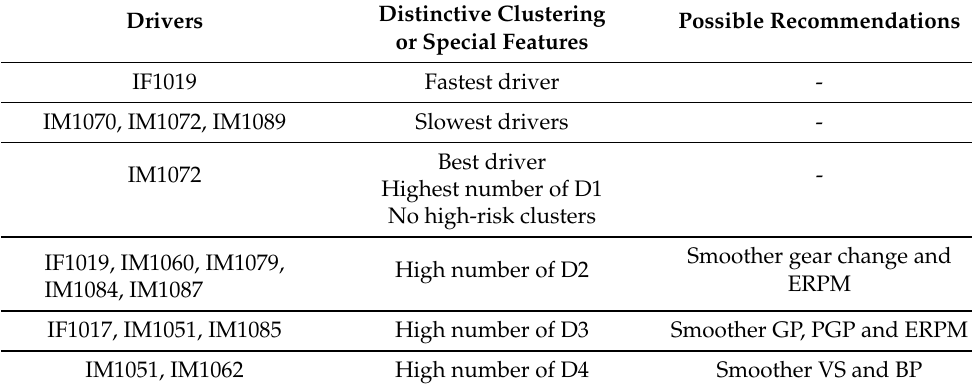
Table 9. Driving style categorization, driver special features, and possible